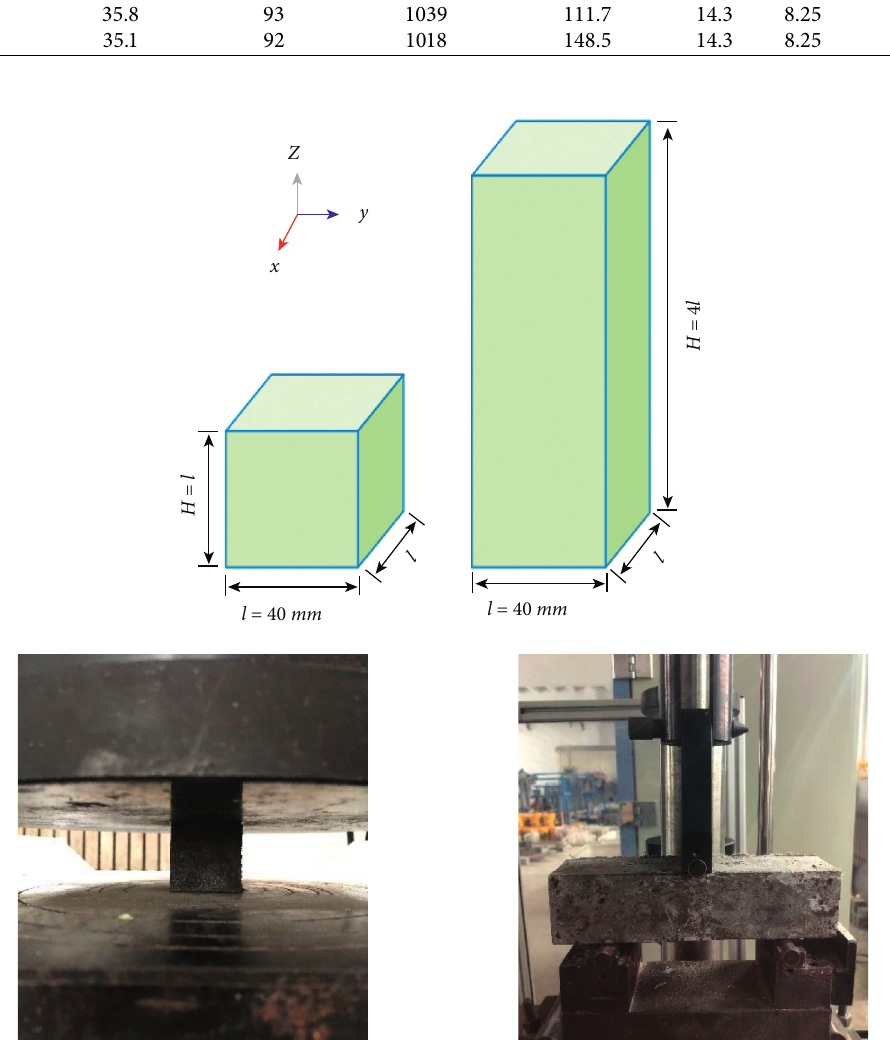
Figure 1: The geometric dimensions and tests of cubic samples and prismatic samples.